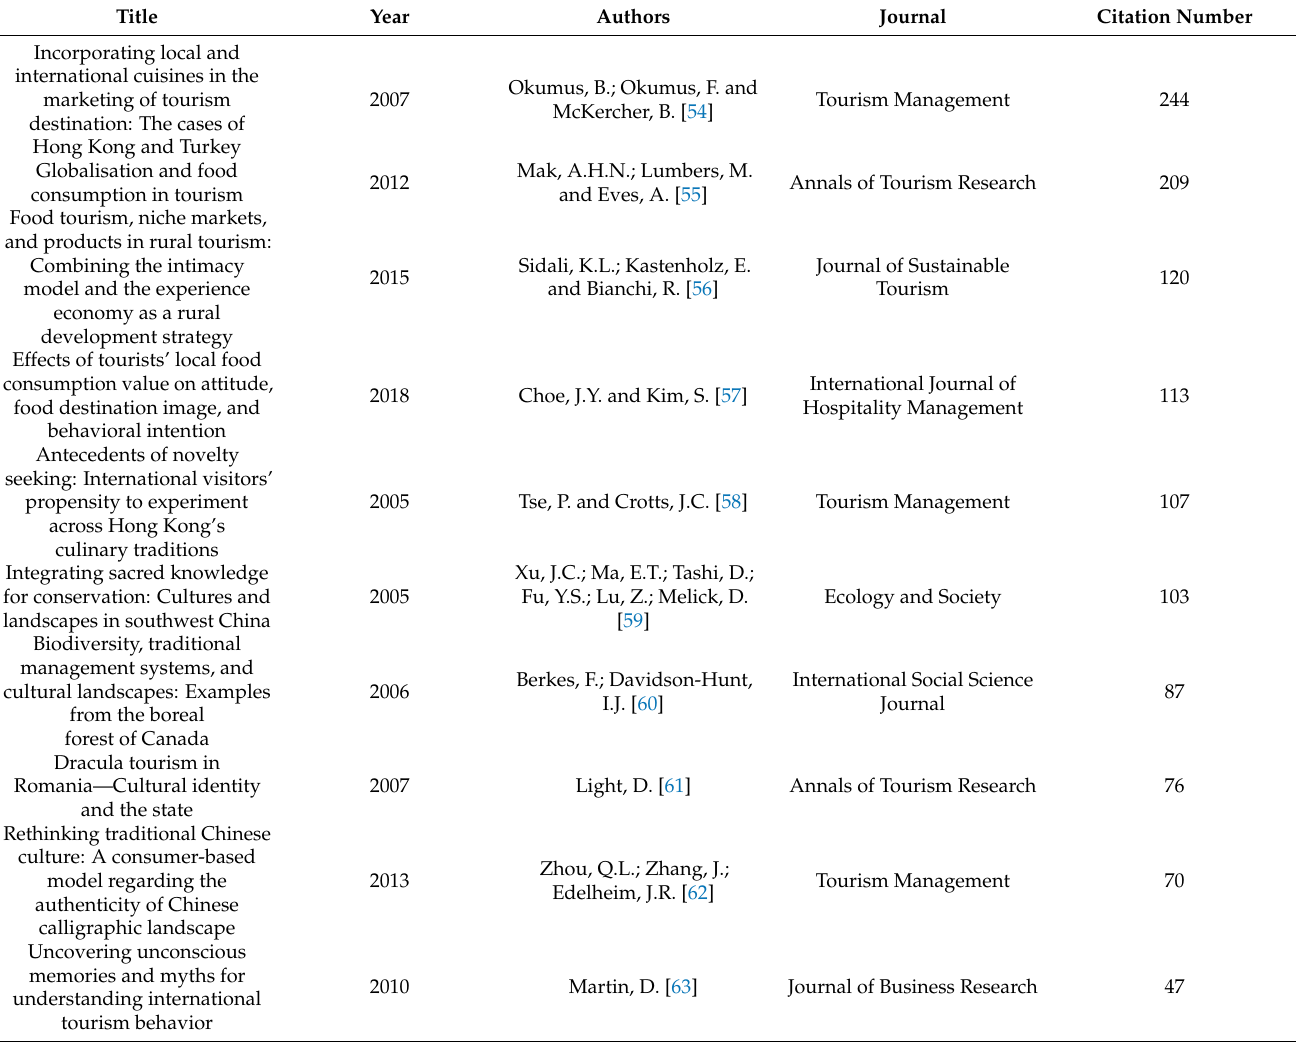
Table 2. Top 10 journal papers on WOS ordered by citation